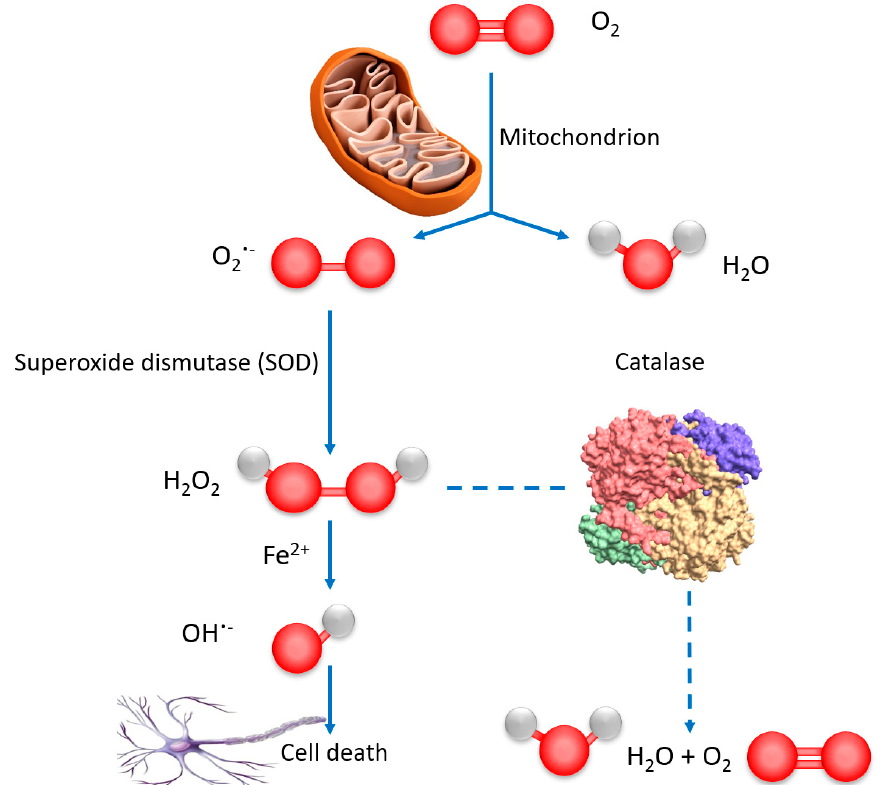
Figure 8. Scheme of reactive oxygen species (ROS) generation and organism self-defense by natural enzymes. The generated ROS levels are principally linked to mitochondria. The superoxide radicals O 2 − are converted to less toxic H 2 O 2 by the enzyme superoxide dismutase (SOD). In the presence of Fe 2 + , some of the H 2 O 2 molecules can be reduced to highly reactive OH − ROS, which attacks various biomolecules (proteins, DNA, and lipids) and causes cell death. Catalase blocks that pathway and saves the organisms by decomposing H 2 O 2 into harmless water and oxygen [44].